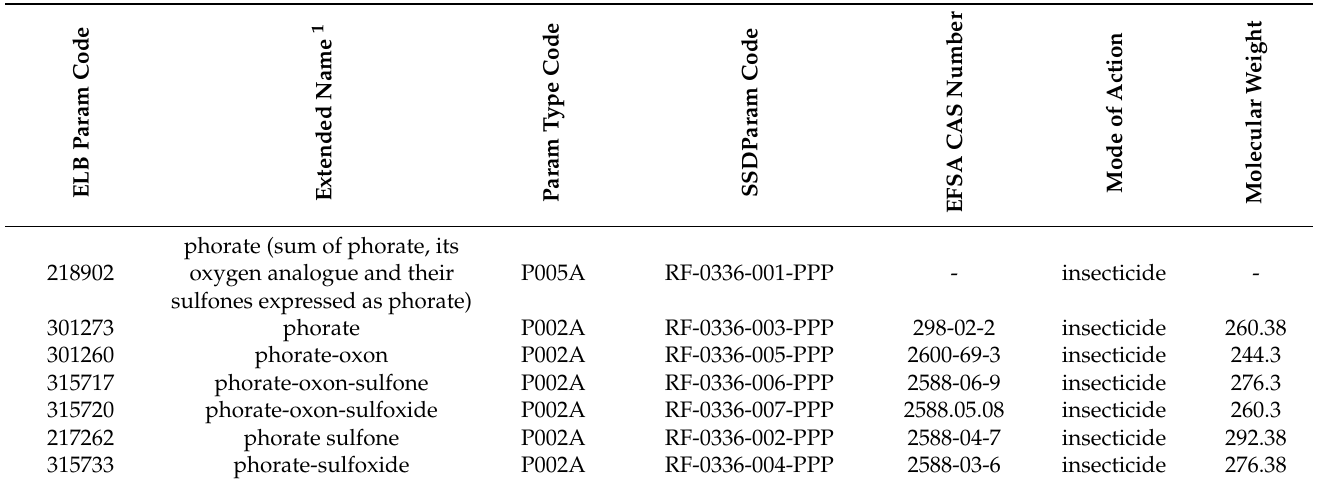
Table A4. Example for recording residues included in the definition of residues.